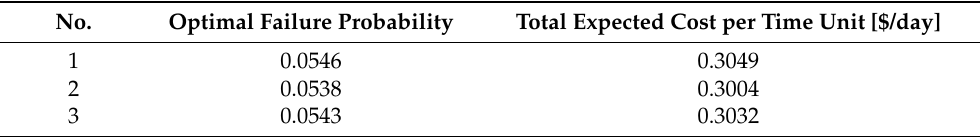
Table 3. Statistics for the results obtained in the maintenance cost